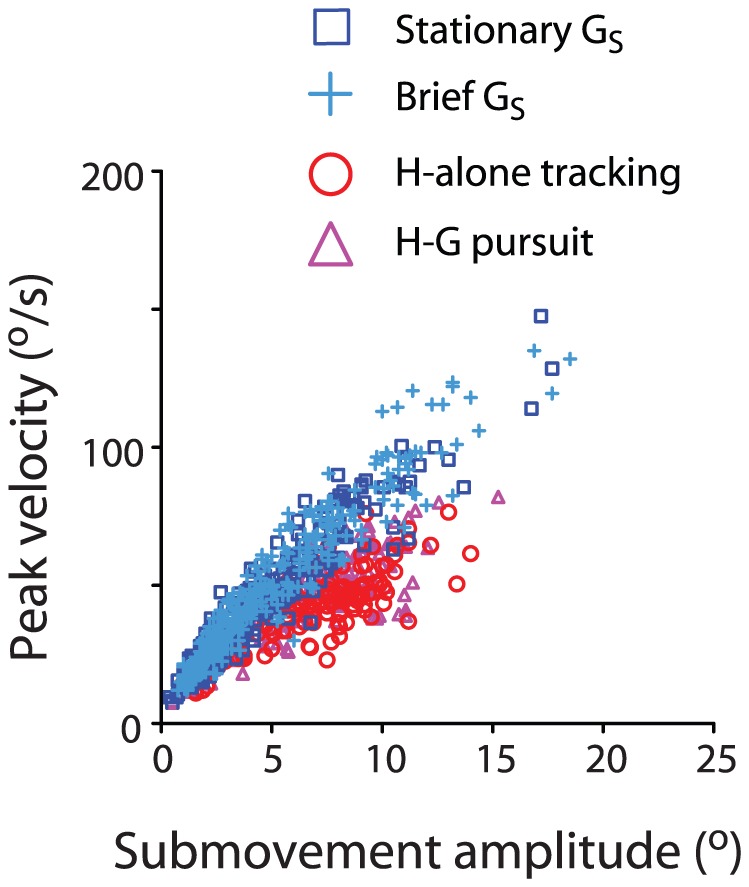
Head tracking movements and eye-head combined gaze shifts distinguished by peak velocity as a function of submovement amplitude.Data includes all submovements.